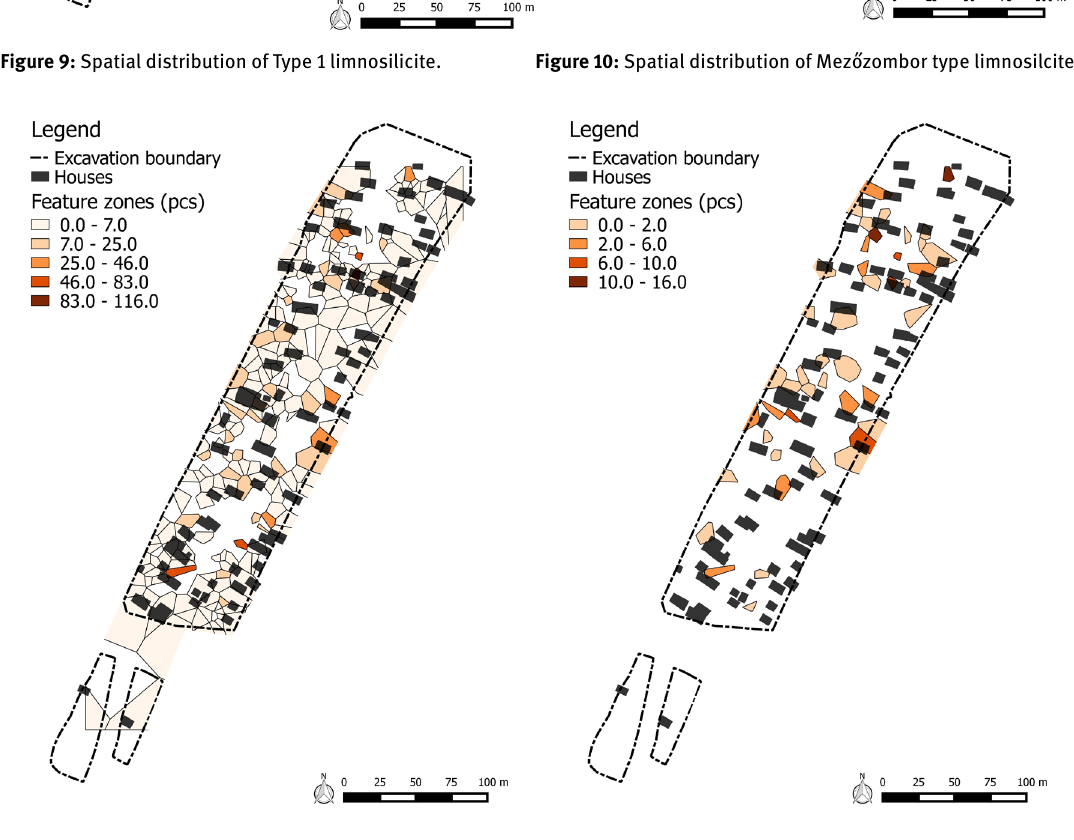
Figure 11: Spatial distribution of obsidian. Figure 12: Spatial distribution of Cracow Jurassic